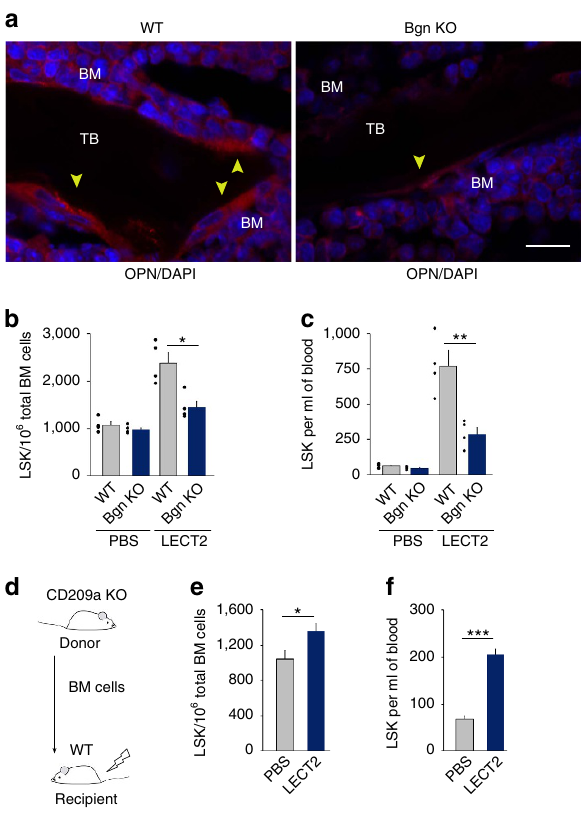
Figure 5 | Osteolineage cells partly mediate the effect of LECT2 on HSC expansion and mobilization. ( a ) Representative tissue expression of OPN in the BM of WT and Bgn (cid:2) /0 mice. Anatomical landmarks are indicated: bone marrow (BM) and trabecular bone (TB). The OPN positive cells are indicated by arrow heads. The scale bar represents 20 m m. ( b ) The number of LSK cells in the BM of WTor Bgn (cid:2) /0 mice after PBS or LECT2 treatment. ( c ) The number of LSK cells in the blood of WTor Bgn (cid:2) /0 mice after PBS or LECT2 treatment. ( d ) The protocol used to produce chimaeras of WT mice with BM cells from CD209a KO mice. ( e ) Effect of LECT2 on LSK cell number in the BM of WT mice with BM cells from CD209a KO mice. ( f ) Effect of LECT2 on LSK cell number in the blood of WT mice with BM cells from CD209a KO mice; n ¼ 4. The small black dots in histograms are data points. The data represent means ± s.e.m. The data are representative of two independent experiments. * P o 0.05, ** P o 0.01, *** P o 0.001 using one-way ANOVA. Furthermore, BM cells from CD209a KO mice were injected intravenously (i.v.) into lethally irradiated (9 Gy) WT mice that expressed CD209a in osteolineage cells but not in macrophages (Fig. 5d). In these mice, LECT2 still led to the increase of LSK cell number in the BM and blood, but only a 1.3-fold and 3.1-fold increase in the BM and blood, respectively (Fig. 5e,f). TNF secretion is suppressed by the LECT2 signal . Because LSK cells did not express CD209a (Fig. 3h), we hypothesized that secreted soluble factors from macrophages or osteolineage cells might mediate the effect of LECT2. The data from transcriptome sequencing revealed that several cytokines were downregulated in the BM after LECT2 treatment (Supplementary Fig. 6a). More- over, the protein levels of TNF and CC motif chemokine ligand (CCL)3 were downregulated to o 25% of the control levels in the BM supernatant of LECT2-treated mice (Supplementary Fig. 6b).